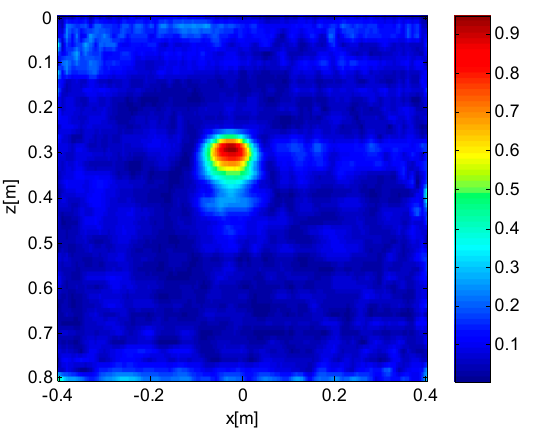
Figure 2. Target reconstruction with an observation domain equal to 0.8 m.